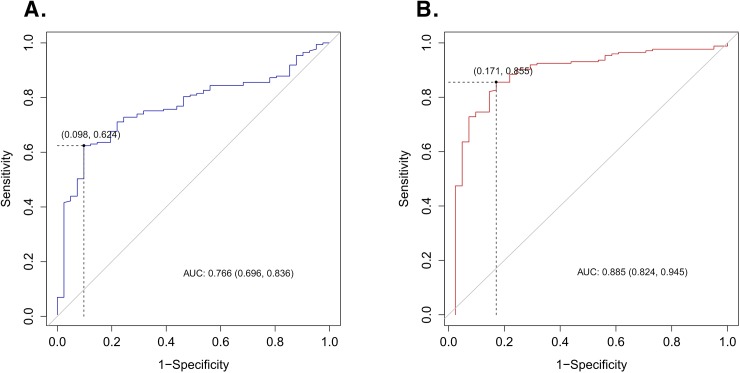
Receiver operating characteristic (ROC) curve of uric acid stones for mean stone density and stone heterogeneity index.(A) The area under the ROC curve (AUC) for the mean stone density was 0.766 (95% confidence interval [CI], 0.696–0.836) and the cut-off value was 572.3 HU. (B) The AUC for the stone heterogeneity index was 0.885 (95% CI, 0.824–0.945) and the cut-off value was 140.4 HU.